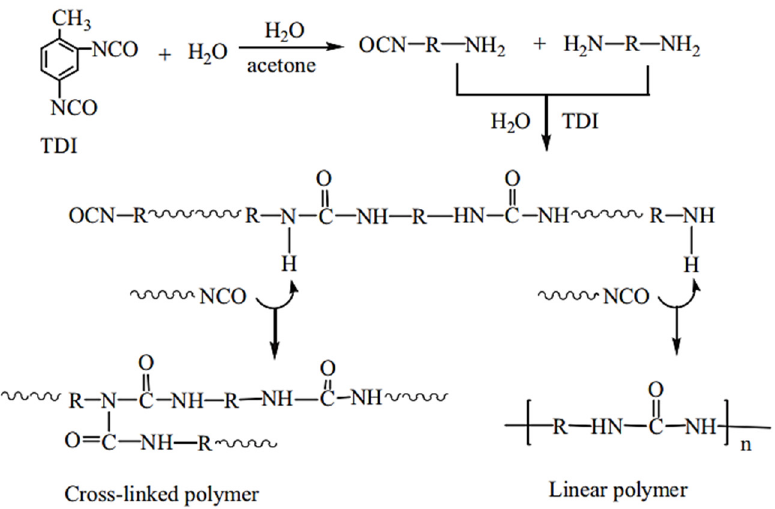
Figure 52. Schematic presentation of porous polyurea absorbent through precipitation polymerization of TDI and water. From reference [79].